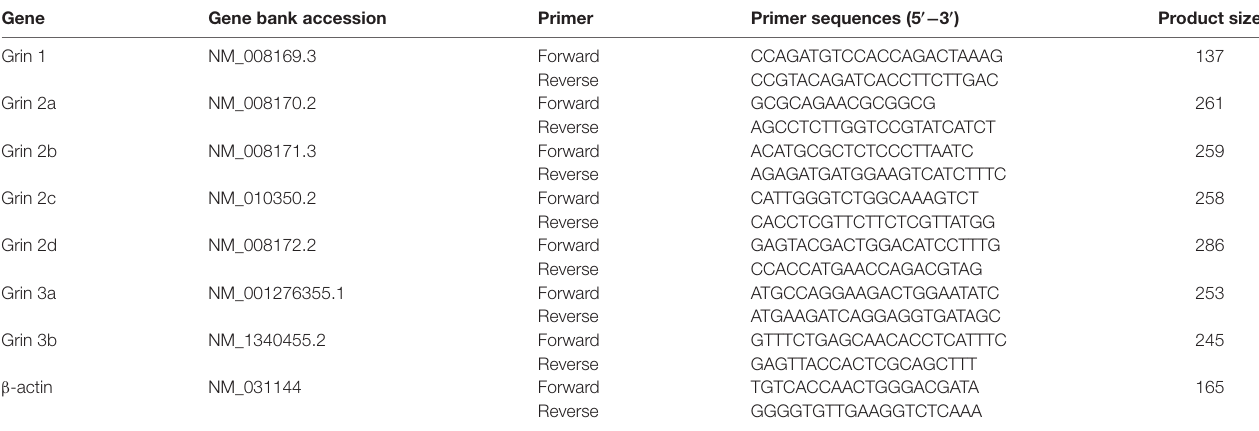
TABLE 1 | Primers’ sequences used for